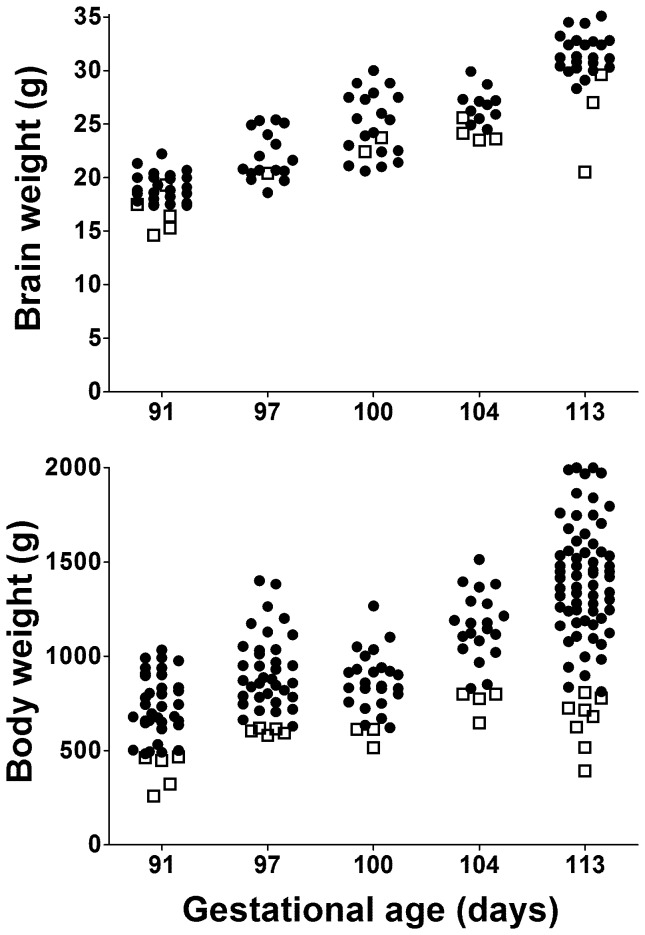
Brain and body weights of piglets over a range of gestational ages.Closed circles represent normal body weight animals and open squares represent animals with body weight <10th centile. Not all piglets had brain weight recorded. Note the spread of weights within a given gestational age is greater for the body than for the brain implying that brain growth is relatively preserved even when body weight is low.